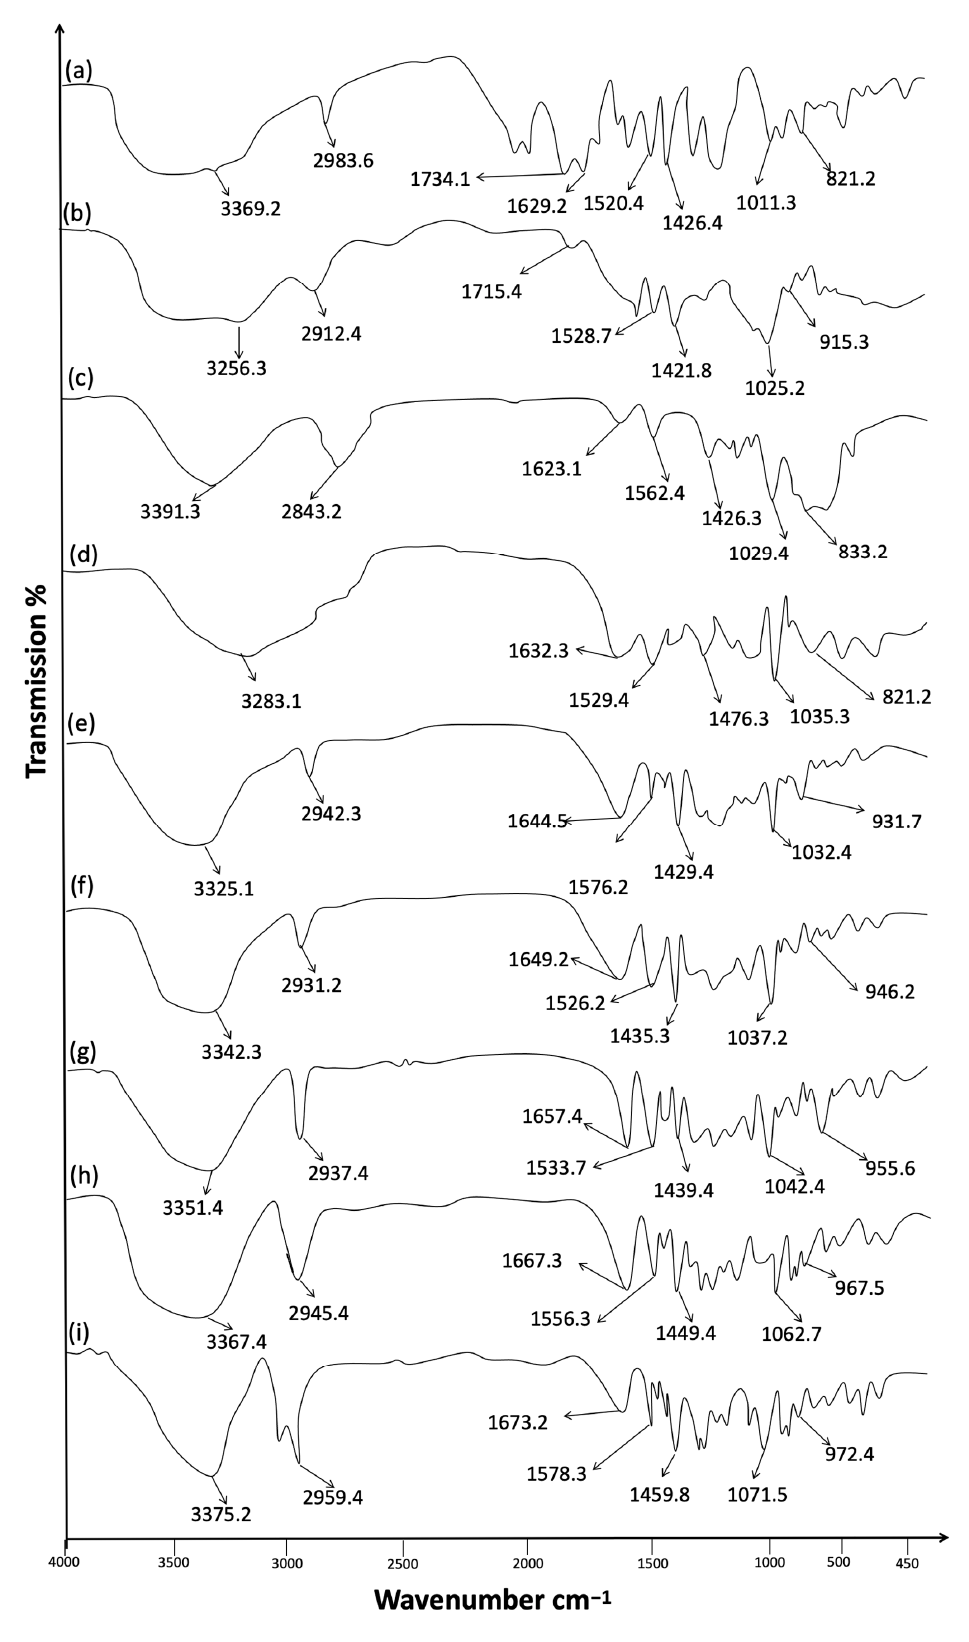
Figure 1. ATR-FTIR spectrum ( a ) Esomeprazole ( b ) Chondotrin sulfate ( c ) HPMC ( d ) Calcium alginate ( e ) F1 ( f ) F2 ( g ) F3 ( h ) F4 ( i )